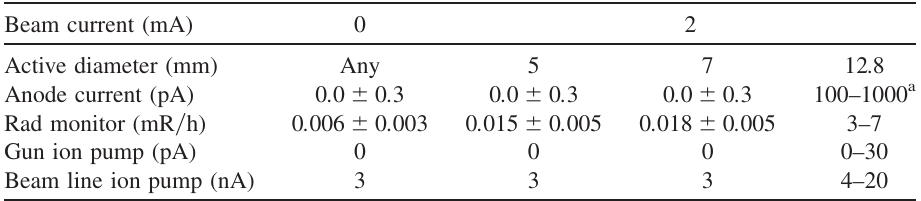
TABLE I. Summary of conditions as a function of active area.